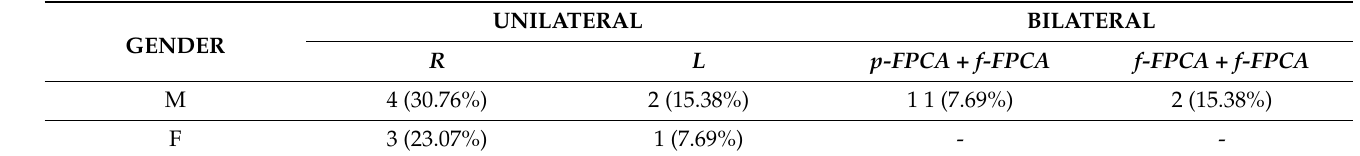
Table 1. Prevalence of different variants of FPCA ( n = 13). M: male, F: female. UNILATERAL BILATERAL GENDER R L p-FPCA +